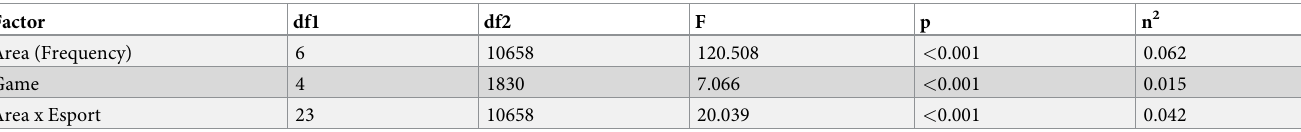
Table 17. Results of the two-factor ANOVA regarding training field engagement in different esports. Factor df1 df2 Area (Frequency)